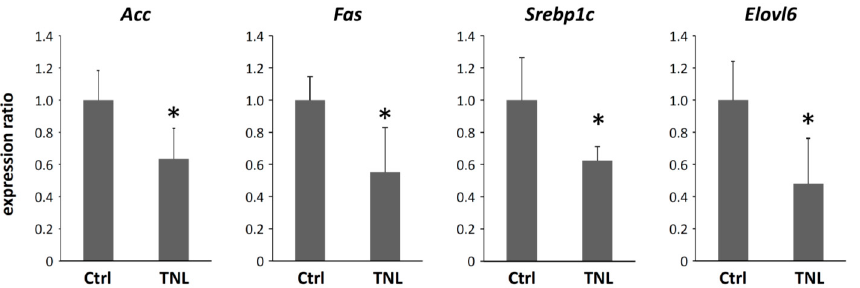
Figure 3. Effects of teneligliptin on the expression levels of genes related to lipogenesis in the livers of experimental mice. Total RNA was isolated from the livers of the experimental mice ( n = 6), and the expression levels of Acc , Fas , Srebp1c and Elovl6 mRNAs were examined using quantitative real-time RT-PCR with specific primers. The values are expressed as the mean ± SD. * p < 0.05 versus the control group.